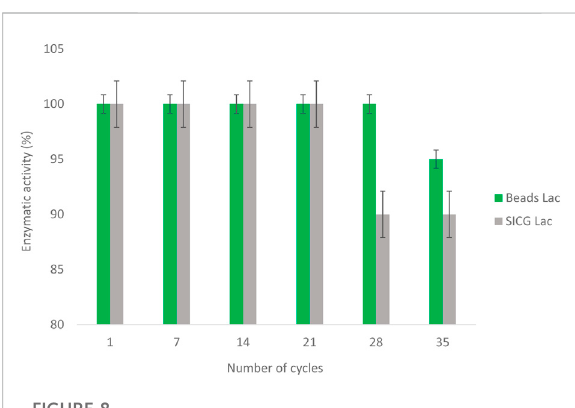
FIGURE 8 Residual activity of free and immobilized biocatalysts during 35 cycles